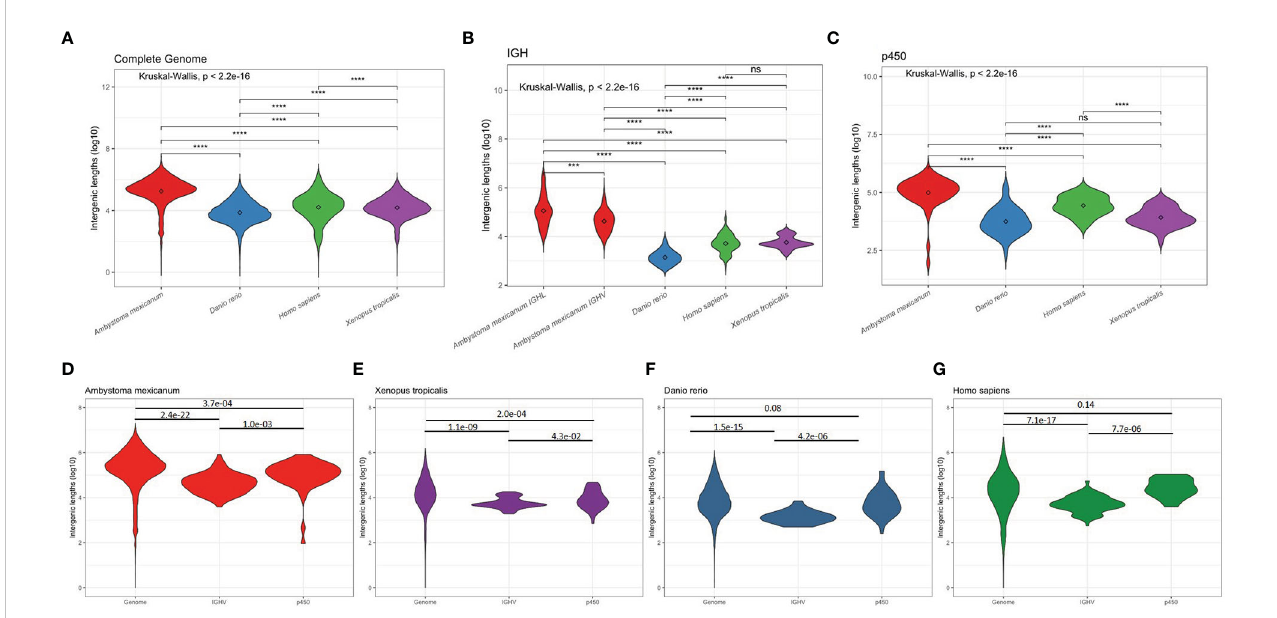
FIGURE 7 Intergenic distances by species. Violin plots depicting overall coding to coding gene intergenic distance distribution across the whole genome (A) , between IGHV segments (B) , and between cytochrome p450 family gene clusters (C) in (D) A. mexicanum (red), (E) X. tropicalis (purple), (F) D. rerio (blue), and (G) H. sapiens (green). Kruskal-Wallis rank sum test followed by Dunn ’ s multiple comparison tests with Benjamini – Hochberg p